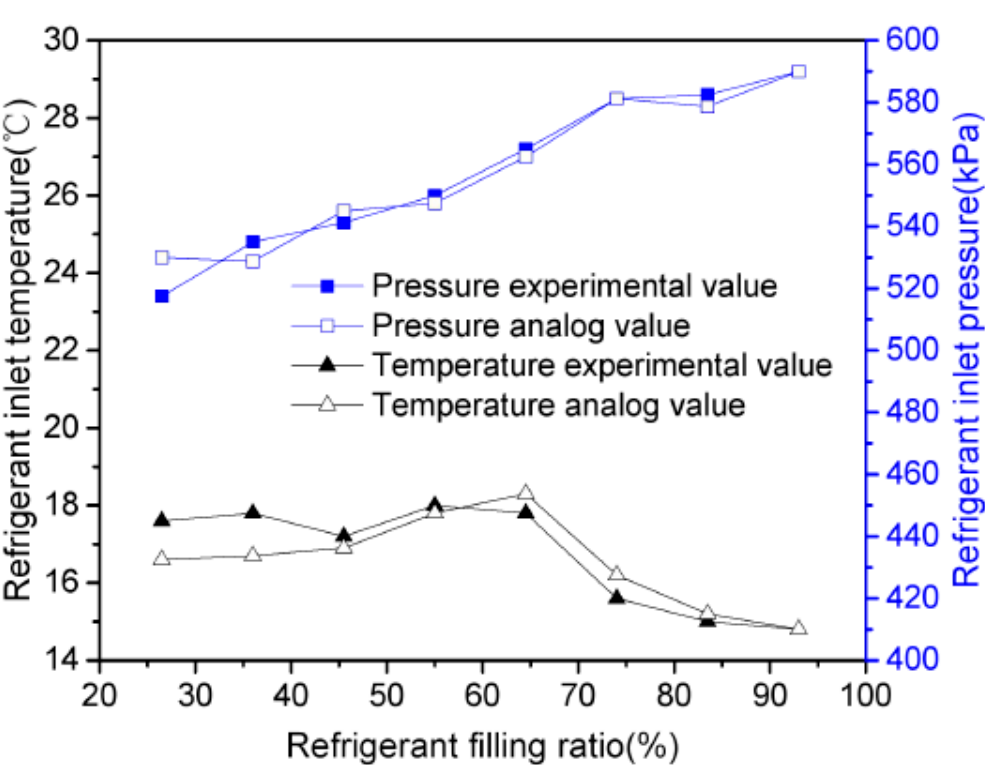
Figure 7. Comparison of temperature and pressure of refrigerant at the inlet of the